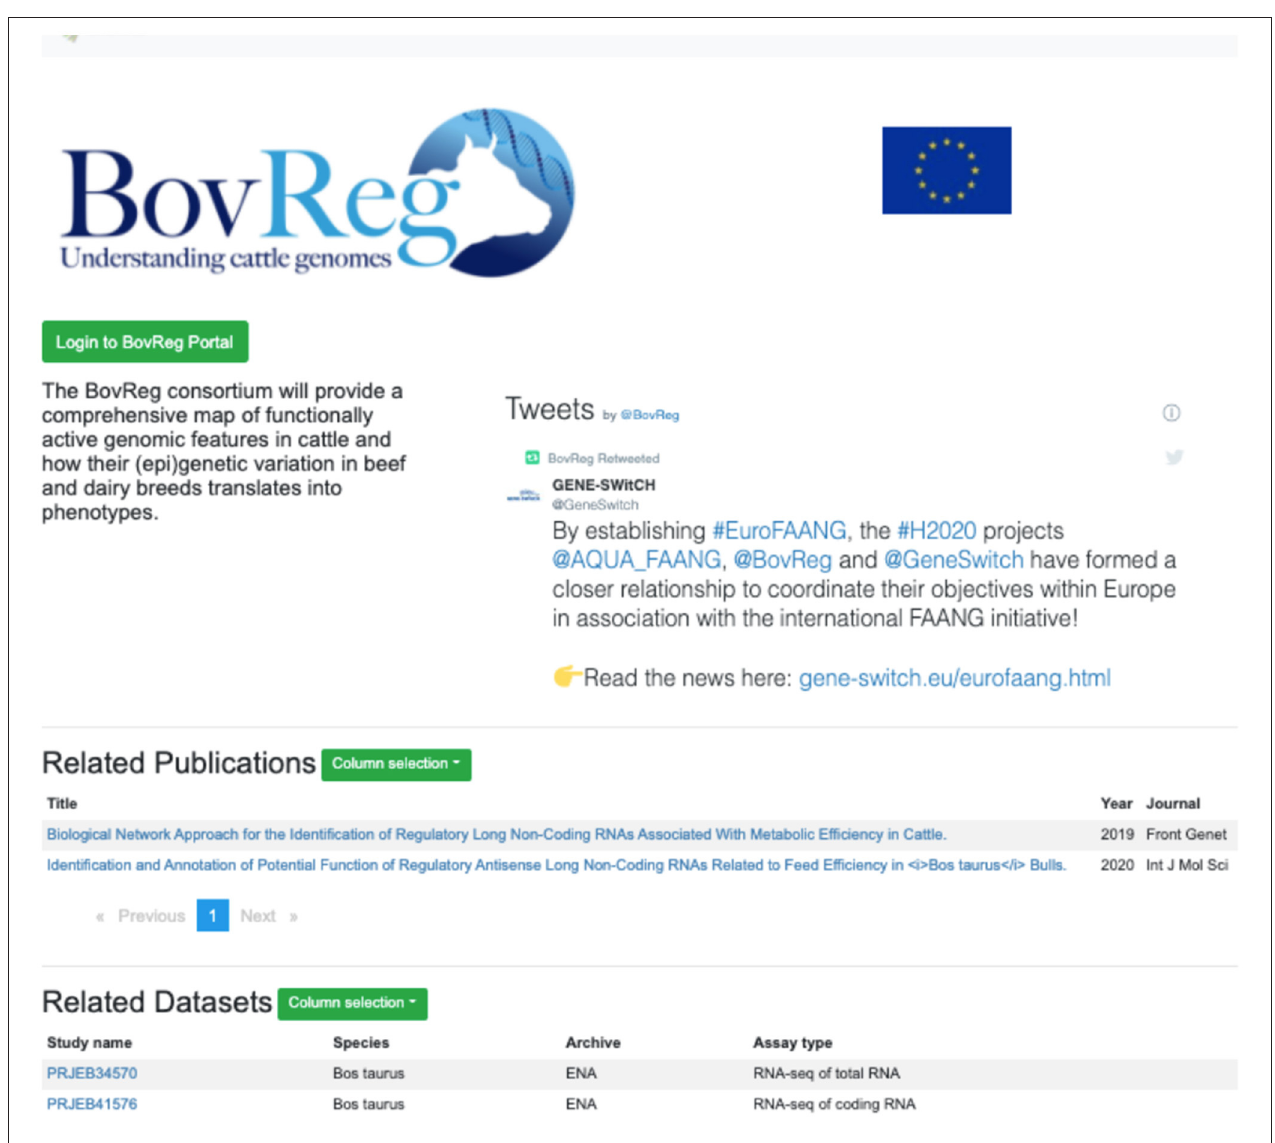
FIGURE 4 | Project-specific subportal views offer the full functionality of the FAANG site pre-filtered to data from a particular consortia (https://data.faang.org/